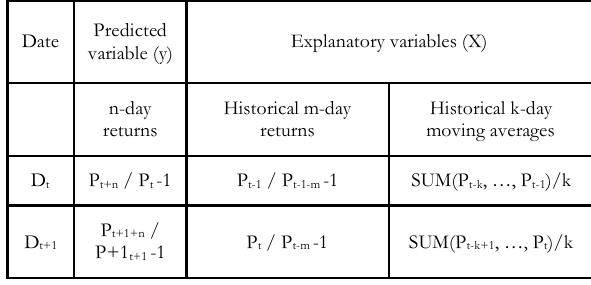
Table 10: An example of data structure of rolling